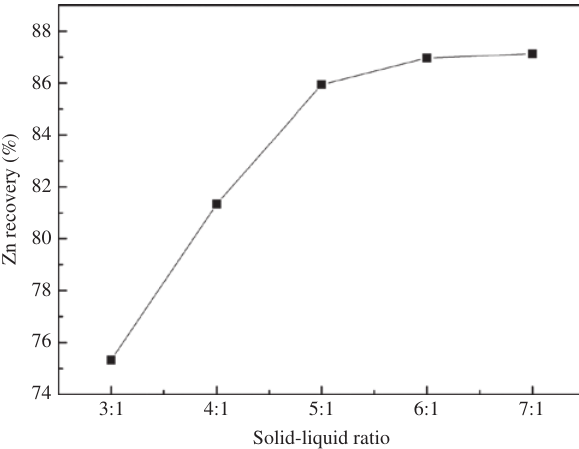
], [NH ], [NH ] , and [NH ]: [NH ] represent the 3 4 3 T 3 4